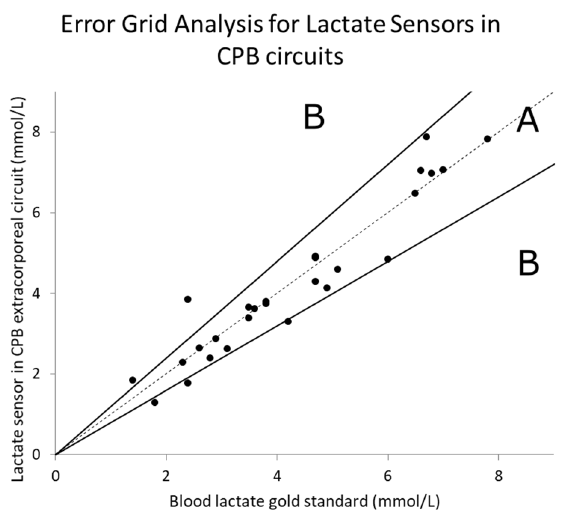
Figure 4. Error grid analysis of lactate measured with NO-releasing lactate sensors compared to that measured using a blood gas analyzer as the control. Zone A depicts a 20% proportional deviation between study and control measurements. The data point (2.4, 3.84) belonged to the first discrete blood gas comparison point in Study 2 (Figure 2b) and is considered an outlier. We used Clarke’s error grid analysis, which is typically used to quantify the clinical accuracy of blood sensors [70].